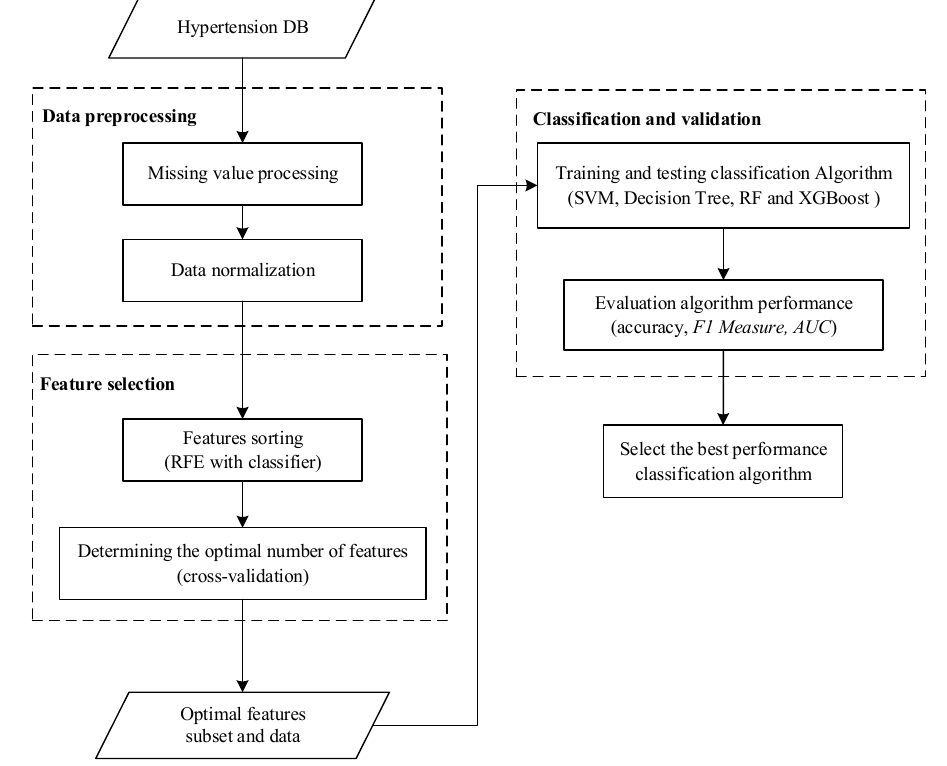
Figure 1. Predictive model construction process. Abbreviations: RF = random forest; AUC = area under receiver operating curve; RFE = recursive feature elimination; XGBoost = extreme gradient boosting; SVM = support vector machine; F1 Measure is calculated according to Equation 17.